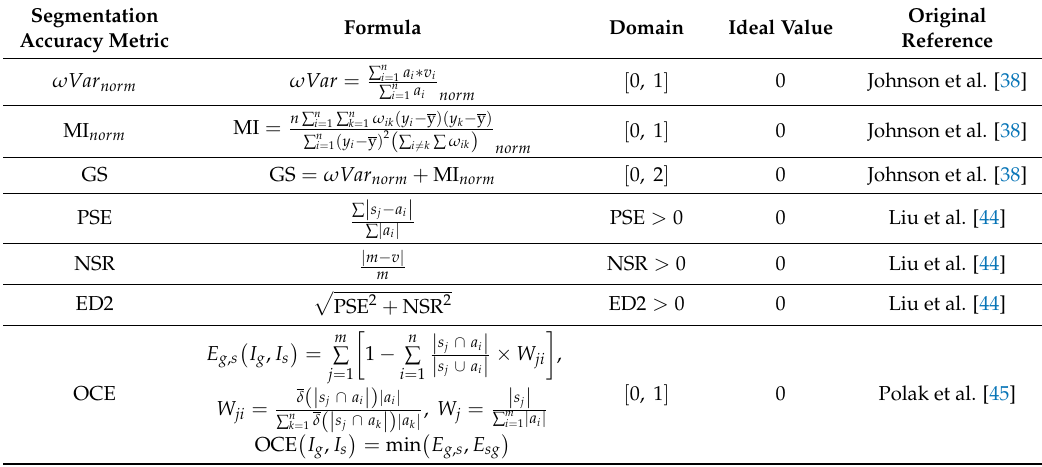
Table 3. Overview of the selected segmentation accuracy metrics. v i is the variance and a i is the area of segment i ; s j defines the area of corresponding ground truth segments ( j ); n is the total number of segments, m denotes the number of reference polygons, and v denotes the number of corresponding matching segments, ω ik is a measure of the spatial proximity, y i and y k are the mean spectral values of regions R i and R k , and y is the mean spectral value of the image, norm is the normalization. I g and I s are the reference image and the segmentation image, respectively, δ , W ji , and W j are the delta function and weight coefficients,